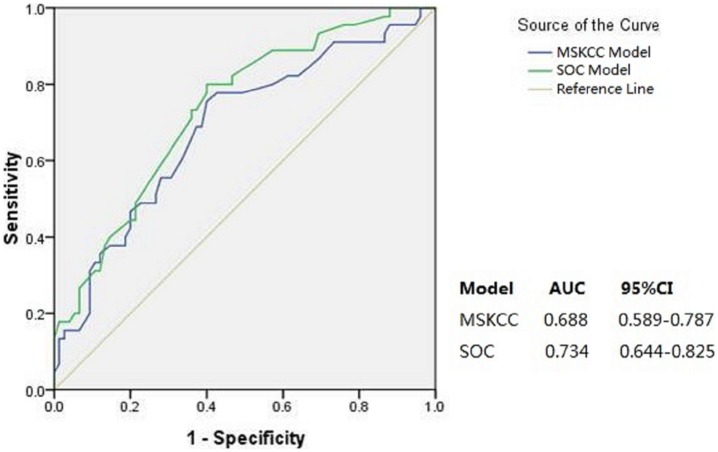
Area under the receiver operating characteristic curve (AUC) for MSKCC and SOC models(n = 120).Diagonal line represents an AUC of 0.5, indicating a score equal to chance.